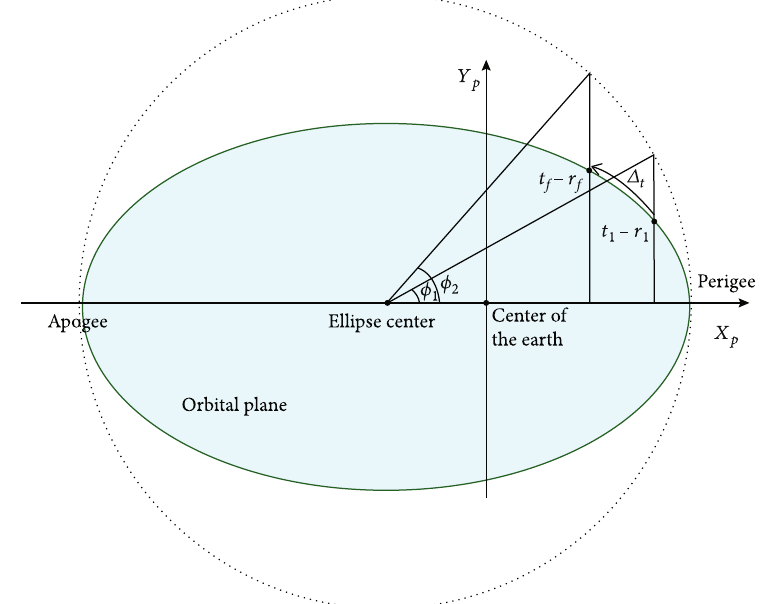
Figure 1: Time-position constraint of